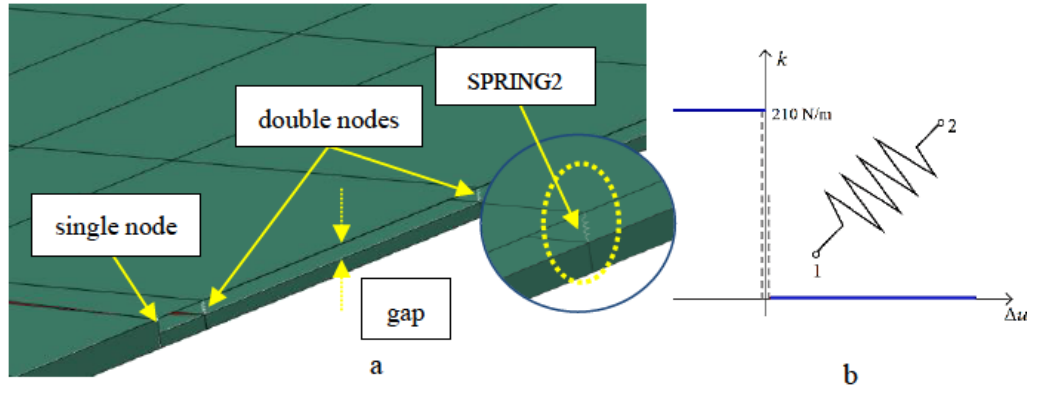
Figure 1: (a) Mesh detail in the debonded region (b) the behavior of spring element Table 1: Model configurations of the car deck